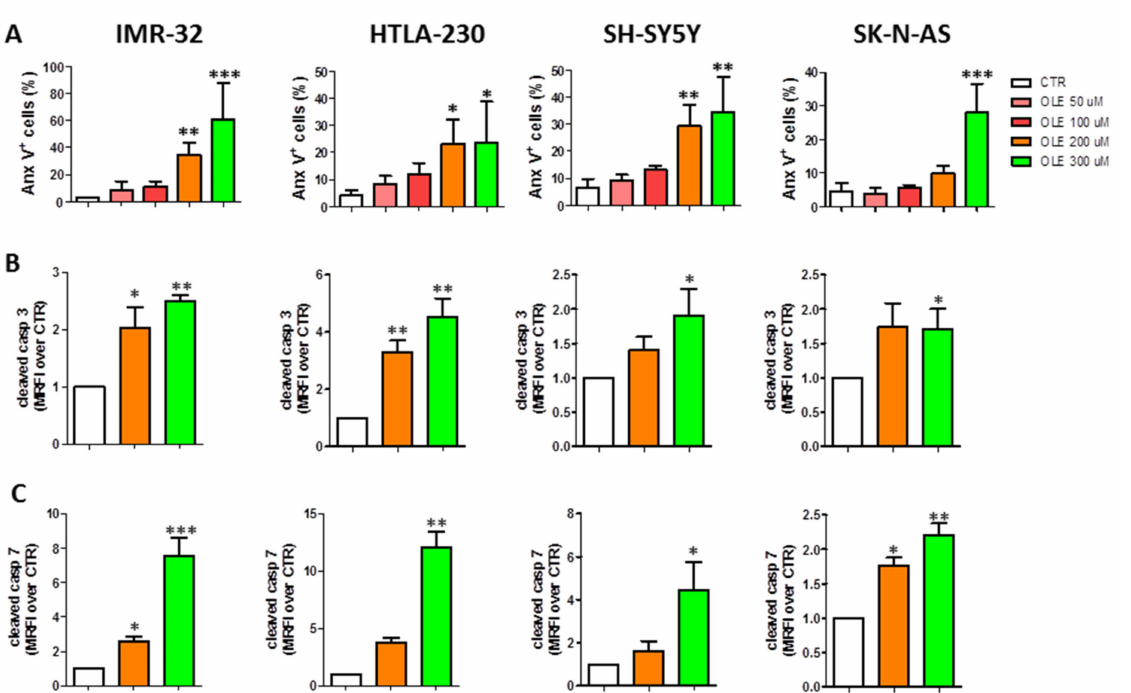
Figure 5. Dose-dependent induction of NB cells apoptosis after OLE treatment. ( A ) Anx-V+ cells determined by FCM. Protein expression levels of the executioner caspases 3 ( B ) and 7 ( C ) assessed by FCM. Data are expressed as mean ± SD of three independent experiments (* p < 0.05, ** p < 0.01, *** p < 0.001 vs. CTR). OLE: olive leaf extract; CTR: control; uM: micromolar; MRFI: mean ratio fluorescence